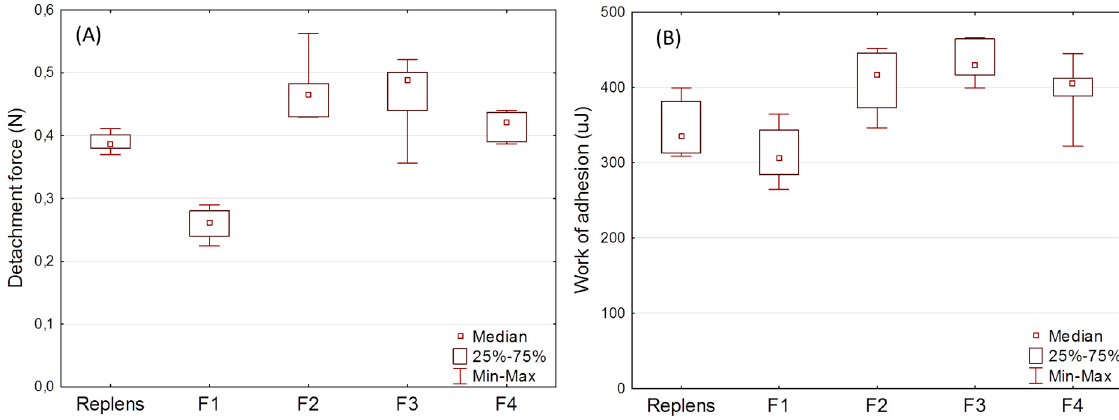
Figure 5. Box-plot graphs presenting mucoadhesive properties: ( A ) maximum force of detachment; ( B ) work of adhesion of formulations F1–F4 and mucoadhesive vaginal gel Replens™ (median; n = 6).